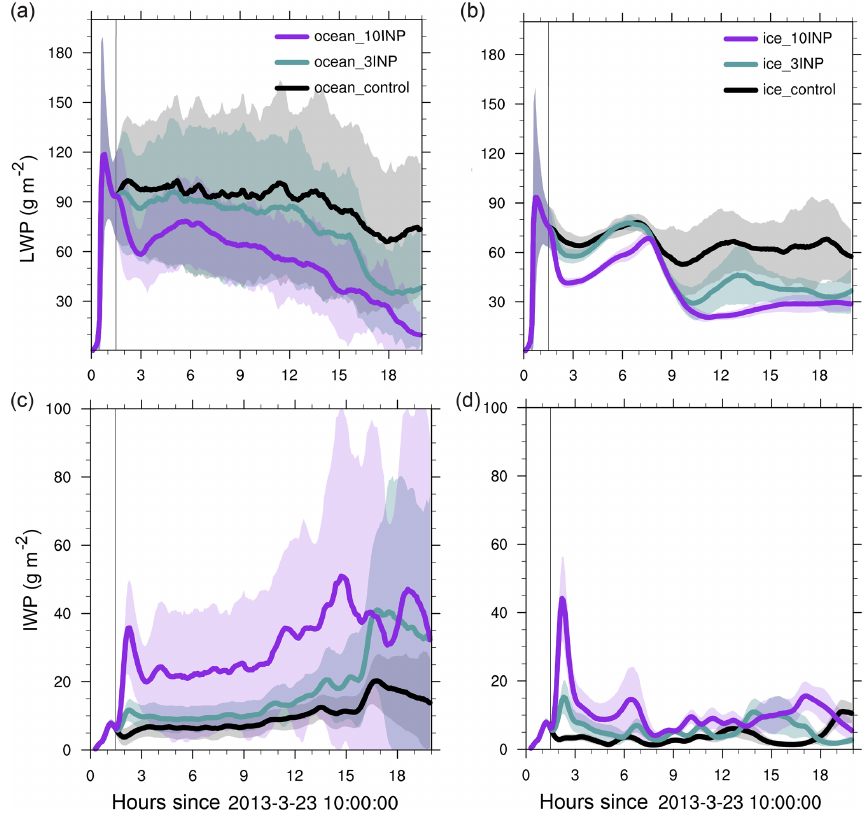
Figure 9. Domain-averaged (a, b) LWP and (c, d) IWP over the open ocean (a, c) and sea ice (b, d) in control and all INP sensitivity simulations. The solid lines depict the means, the shadings the standard deviations. The vertical black lines indicate the INP perturbation